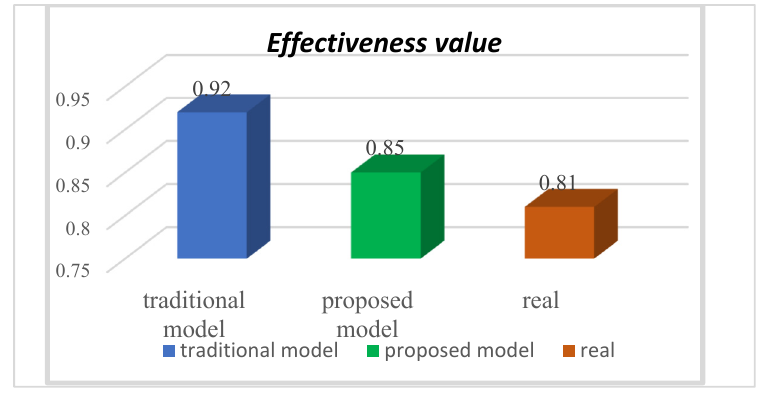
Figure 16. Comparison of the results from the two models.